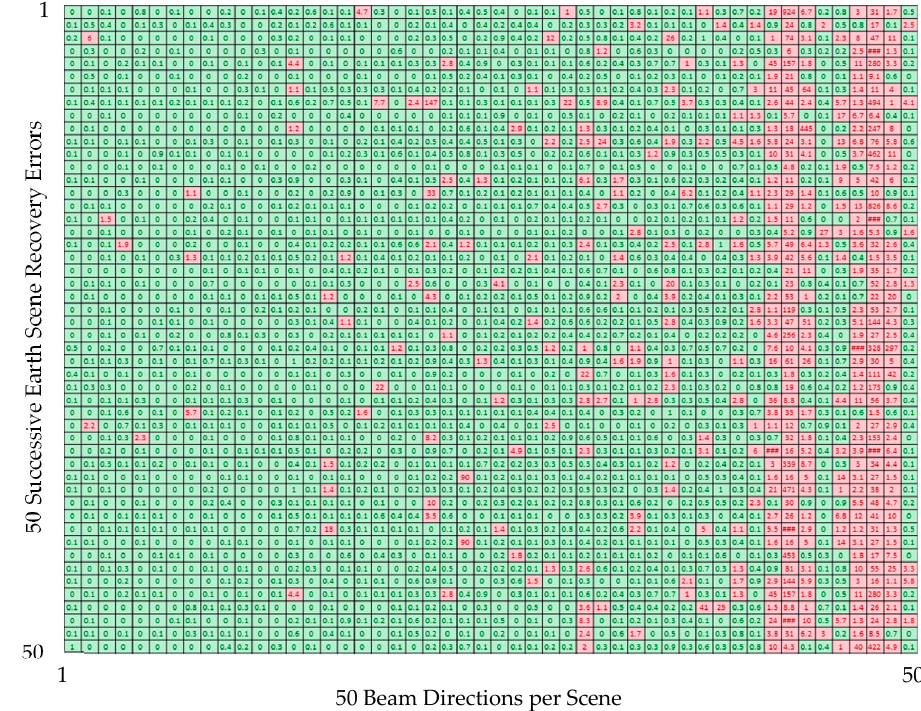
Figure 11. Map of the percentage differences between the two images shown in Figure 10. Green represents an error of within ± 1.0%, and pink represents an error of greater than ± 1.0%.